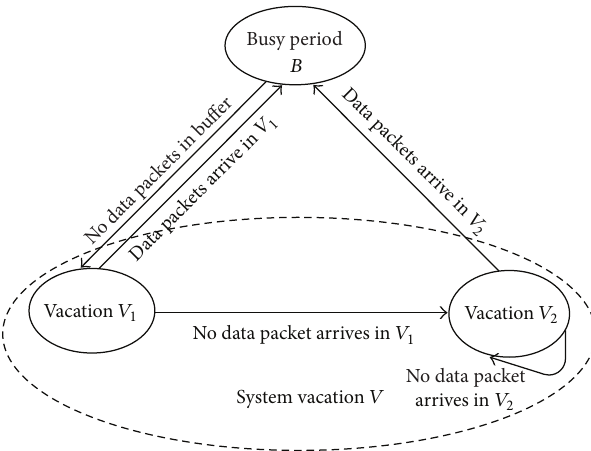
Figure 1: The state transition of the system model.